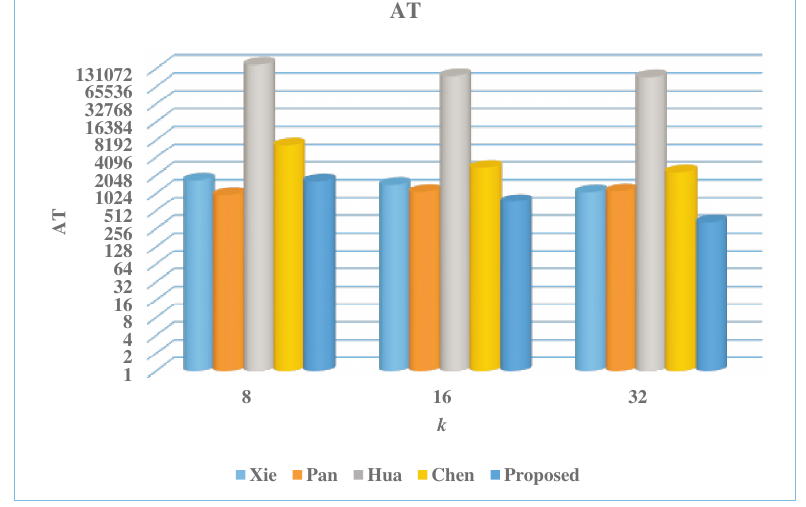
Figure 12. AT results.